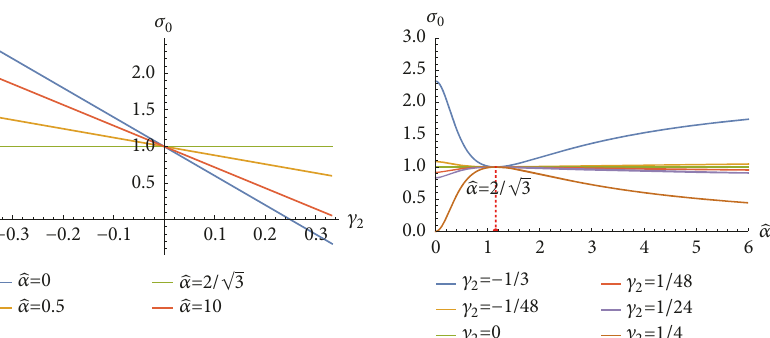
Figure 13: Left plot: the DC conductivity 𝜎 0 versus 𝛾 2 for some fixed ̂𝛼 . Right plot: the DC conductivity 𝜎 0 versus ̂𝛼 for some fixed 𝛾 2 . Here we have set other coupling parameters